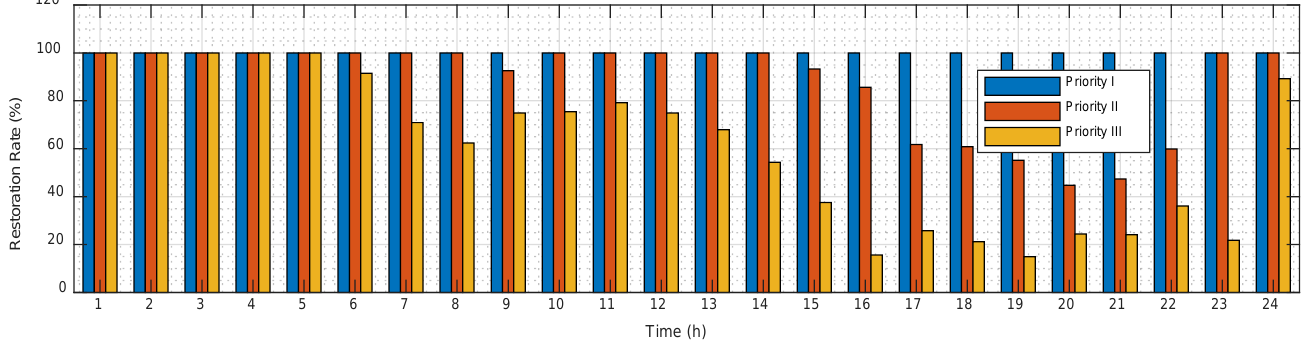
Figure 14. Restoration ratios for Scheme II.